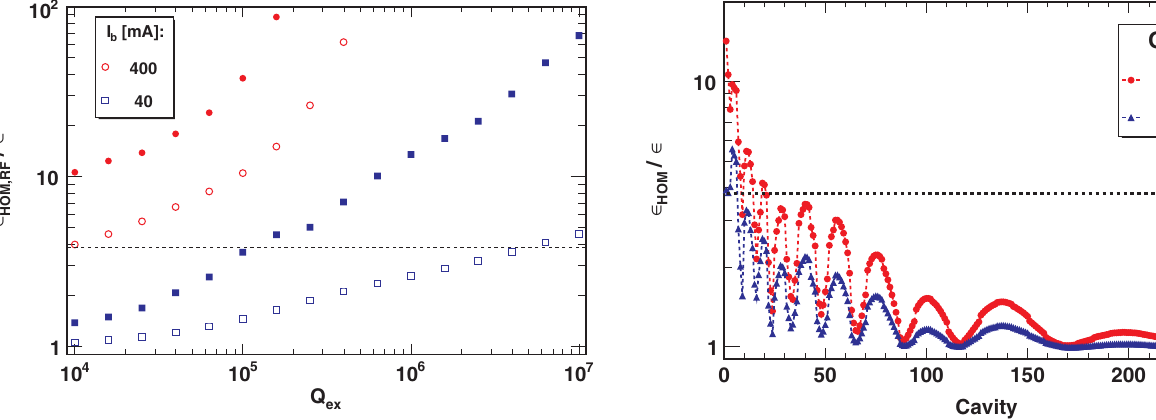
FIG. 13. Average (hollow dots) and maximum (solid dots) longitudinal phase space increase as a function of the damping, where a HOM is resonantly excited. The average increase due to rf errors is indicated with the dashed line. Settings: i ¼ 1408 : 8 MHz , N ¼ 100 , see Table VI. h f HOM